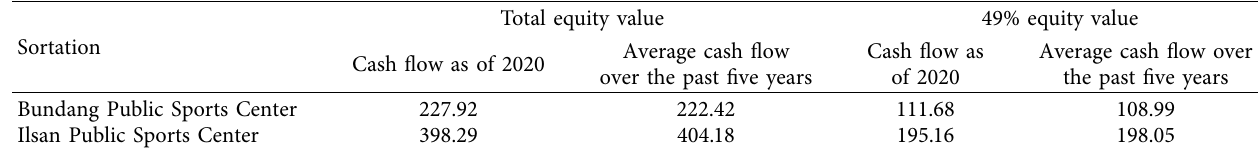
Figure 2: Bundang-Ilsan Public Sports Center share sale structure. Table 6: 49% Estimated value of equity (unit: KRW 100